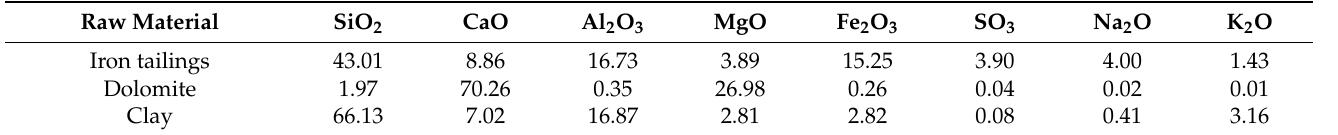
Table 2. Chemical composition of ceramsite raw materials (wt.%).